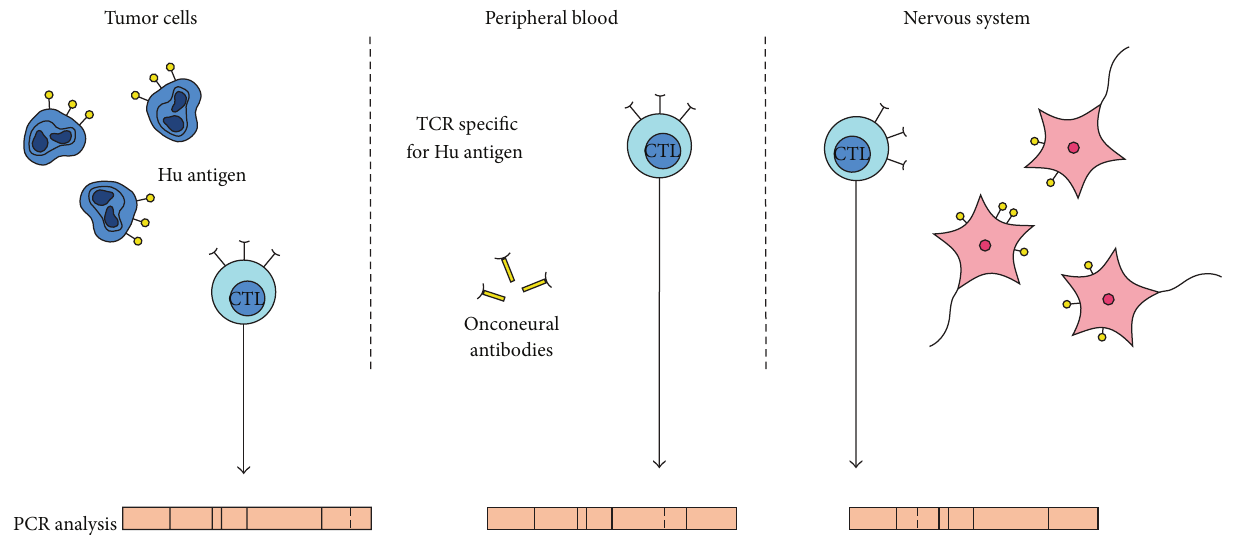
Figure 2: The same Hu antigen is present in both nervous tissue and tumor tissue. Cytotoxic T lymphocytes (CTLs) recognizing it are found in tumors and in the peripheral blood and nervous system. The clones of the TCR receptor appear to be similar in all three locations (based on the findings reported in [35,